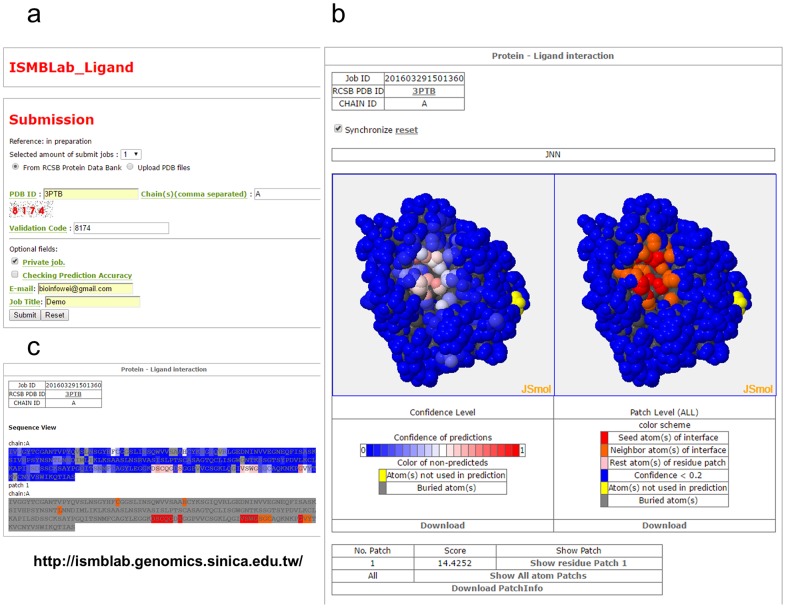
Input and output of the ISMBLab-LIG web server.(a) User can upload structures in PDB format or assign PDB ID with chain identifier for prediction jobs. (b) Two types of prediction results, atom-based confidence level (left panel) and residue-based predicting patches (right panel), are displayed separately with Jmol for interactive 3D structural view. The same color scheme described in Fig 3 is also applied here for confidence level and predicted patches respectively. Both confidence level and patch prediction results can be downloaded as PDB format file where B-factor field contains these information. (c) The prediction results are also shown in sequence-based view. The color scheme is the same as in panel (b).